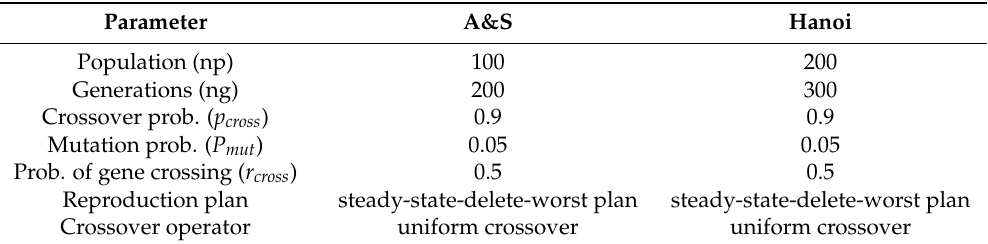
Table 1. Input parameters for the Genetic Algorithm.